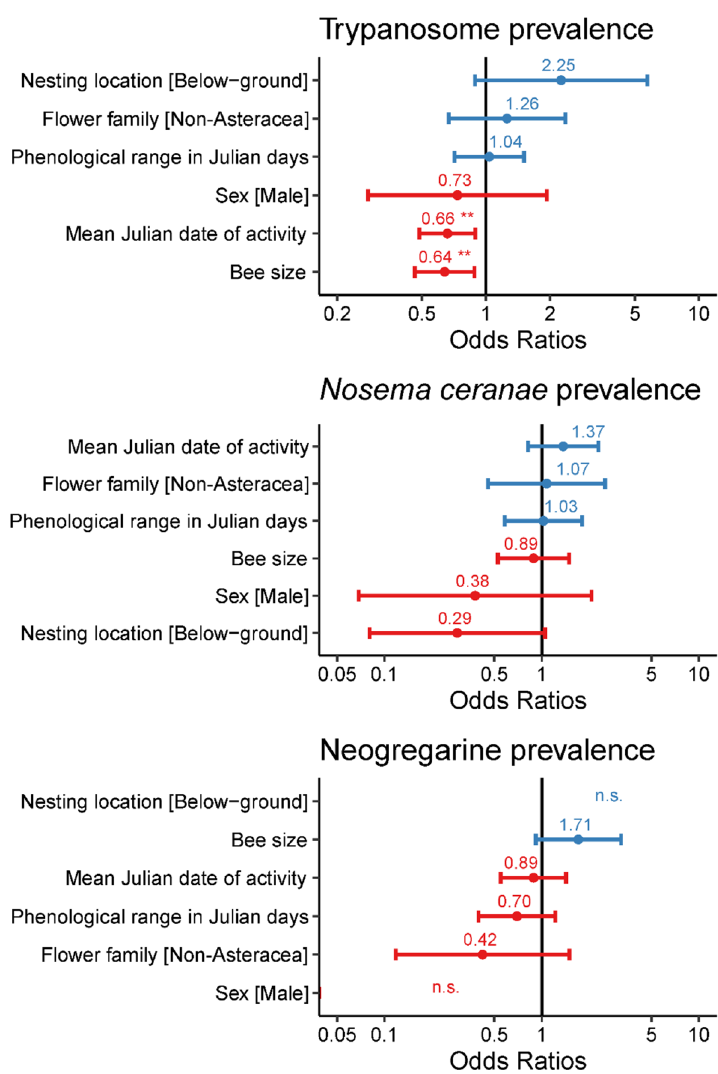
Figure 3. Odds Ratios from binomial models evaluating pathogen prevalence in bee communities by functional traits. Factors sorted from highest to lowest value. Blue indicates a positive odds ratio and red indicates a negative odds ratio. ** P < 0.01. For neogregarines, sex and nesting locations had odds ratios and errors orders of magnitude bigger than other factors, so for visualization n.s. included to indicate they were not